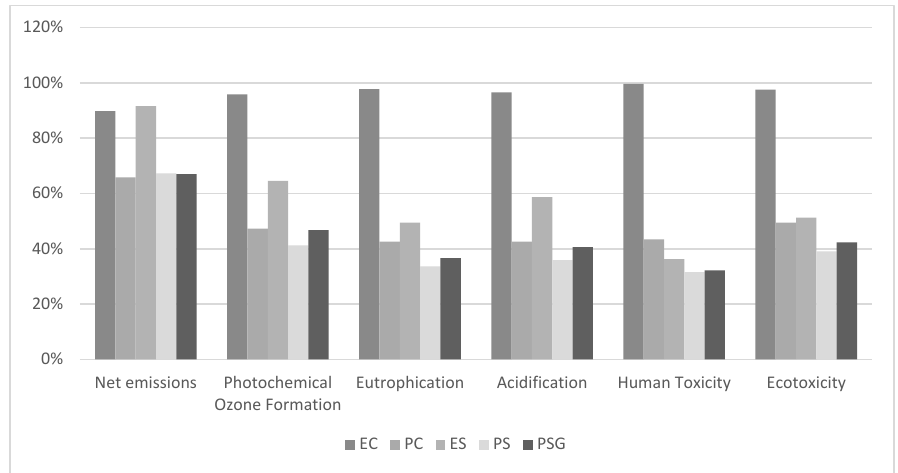
Figure 3. Potential environmental impacts of the tree growing phase. Net emissions: negative values.